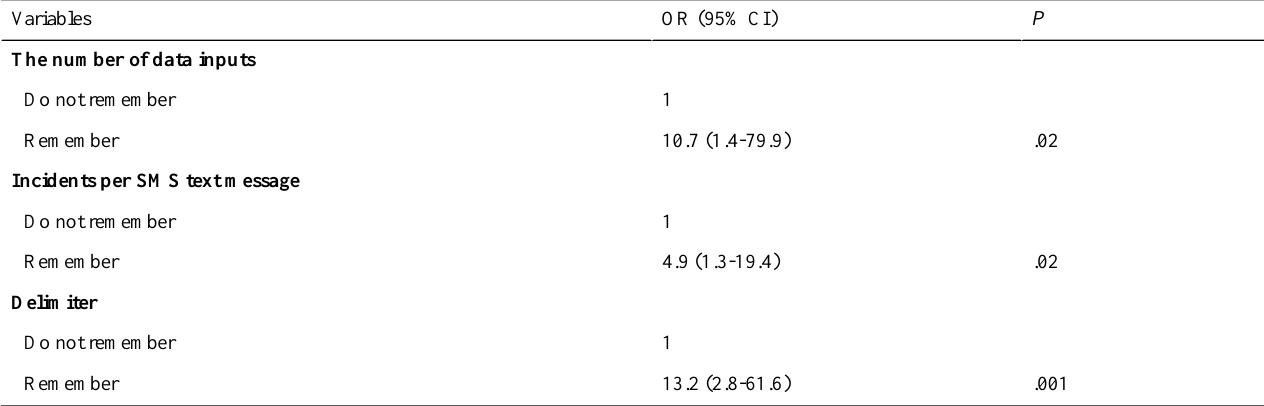
Table 4. Multivariate logistic regression model to study the influence of each component of the basic SMS text message report’s structure on time spent to send an SMS text message report (less than 2 minutes to